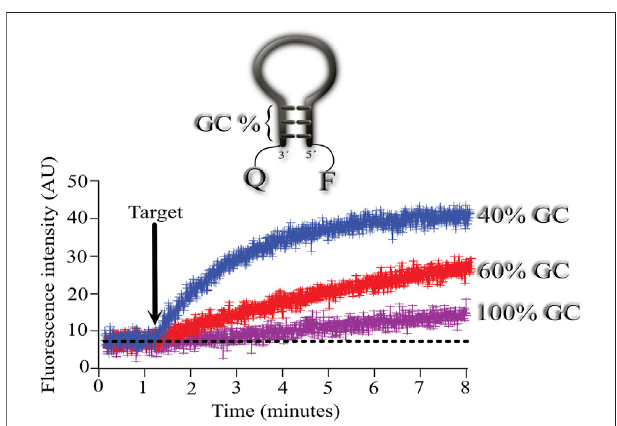
FIGURE 2 | Effect of the percentage of GC content on the hybridization kinetics of the MB-target. Mean ± standard deviation from 6 independent microarrays measuring the mean fl uorescence from at least 6 spots for each microarray. Three MBs with different stems were assayed consisting of 40 (blue), 60 (red) and 100 (fuchsia) % GC content in their stem. Arrow indicates the time of target application to the microarrays. Mean fl uorescence was obtained from regions of interest (ROI) using the plot pro fi le function from ImageJ for each microarray spot and measured overtime (see Supplementary Video S1 ). Then, means from all spots measured overtime were used to calculate the fi nal mean ± standard deviation (see Supplementary Video S1 ). FIGURE 1 | Cartoon illustrating the different molecular conformations of